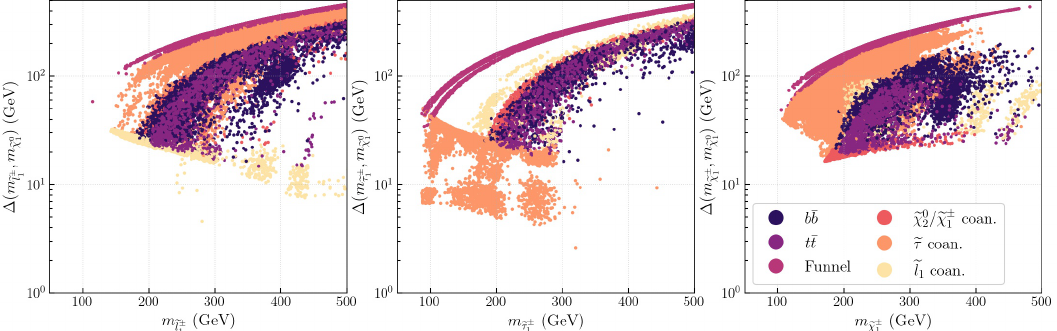
) vs the velocity-weighted annihilation χ 0 (cid:101) 1 | indicated on the left, the wino component | N 11 (cid:113) + N 2 N 2 on the right. 14 13